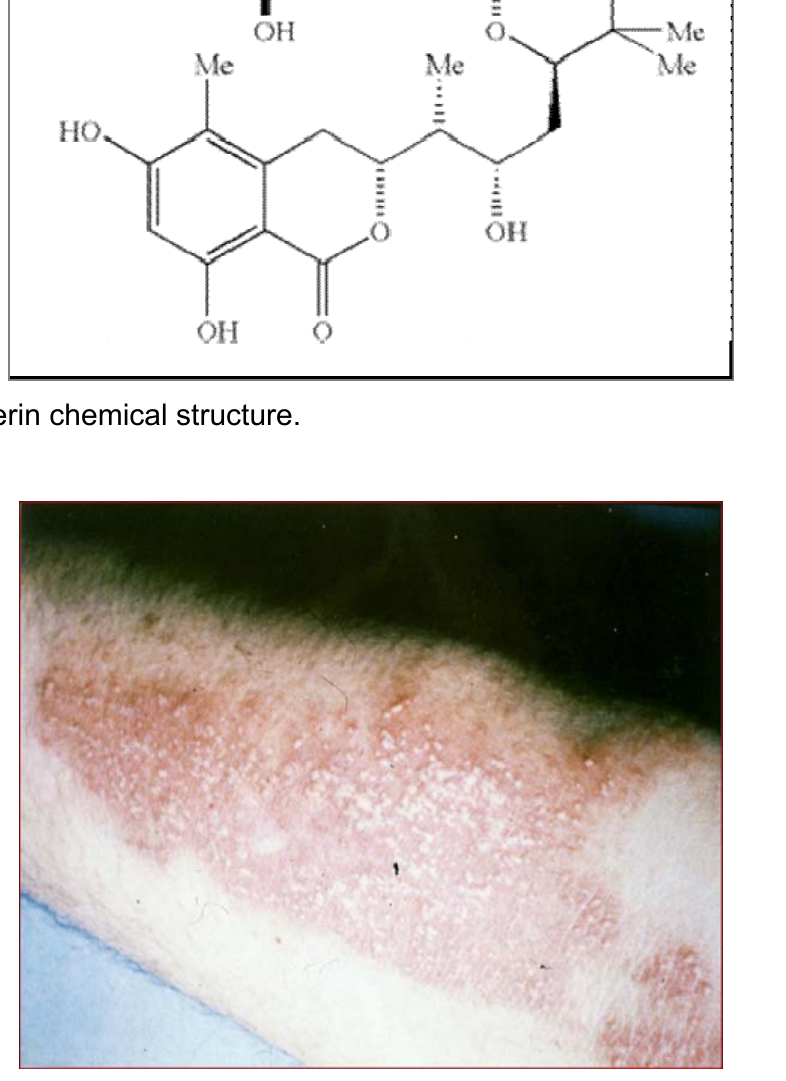
Figure 2. Linear dermatitis on an arm caused by Paederus fuscipes (northern Iran). Erythema and vesicles are the first two typical